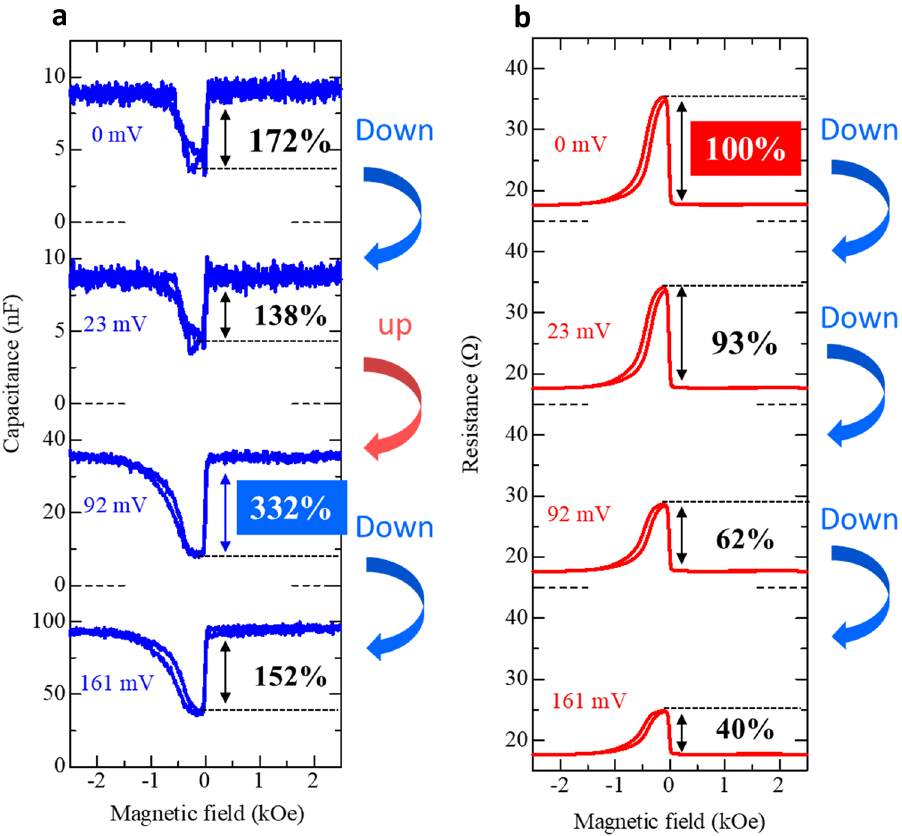
Figure 3. Voltage-induced TMC and TMR curves. ( a ) TMC and ( b ) TMR curves at 160 Hz in an MgO-based MTJ for positive DC bias voltages of 0, 23, 92 and 161 mV. The AC voltage is 2.6 mV rms . Note the